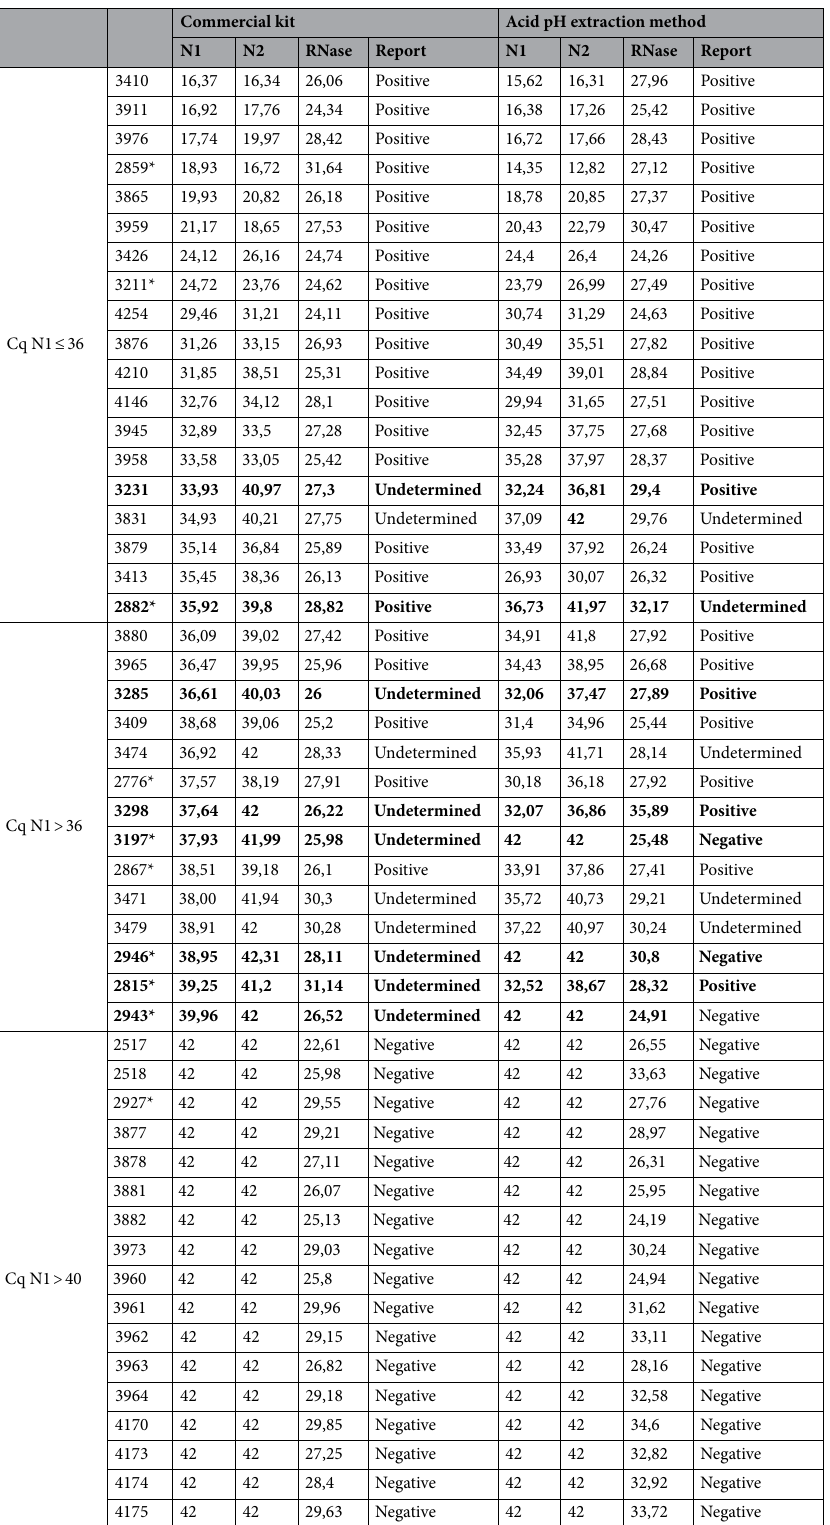
Table 1. Comparative Cq data for the two RNA extraction methods tested. The *denotes extraction was done with 600 µL of Lysis Buffer. All other samples were extracted using 300 µL as described in Materials and Methods. Bold letters show samples that changed their report’s results. A Cq value of 42 was considered for those negative q-PCR results where no Cq value is provided in order to calculate the difference between Cq